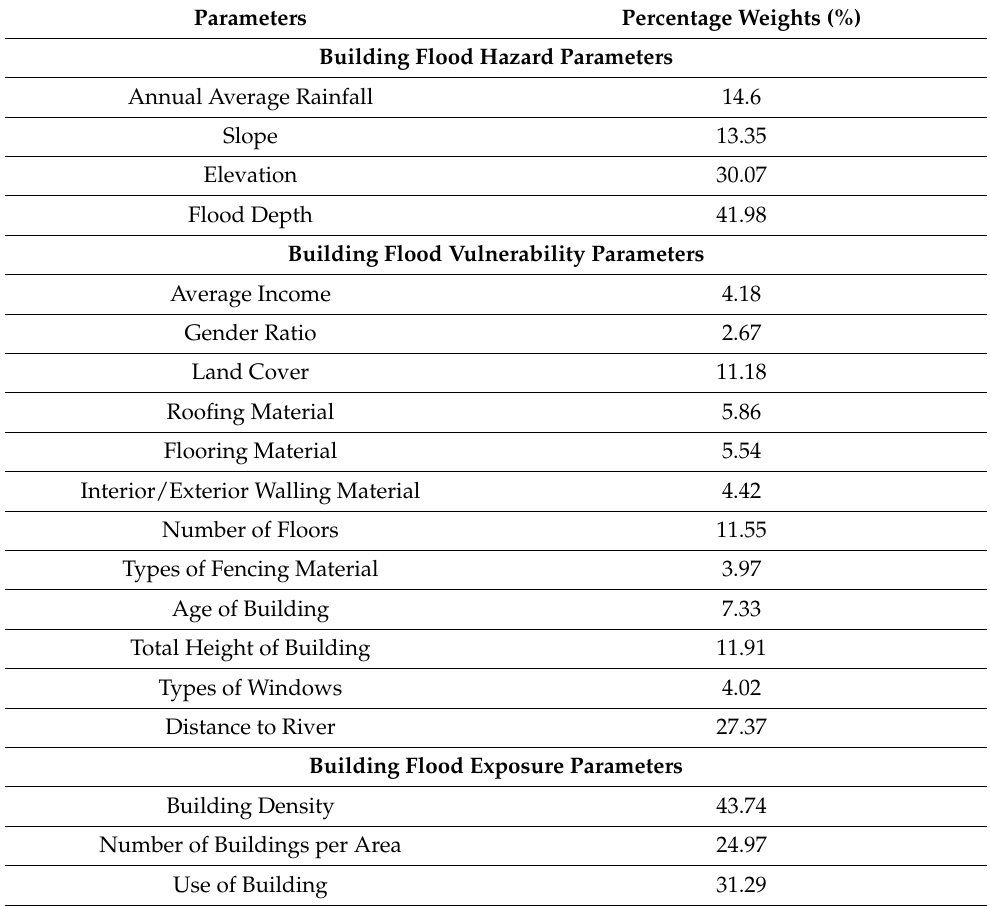
Table 3. Parameters with feature class, feature weight, and percentage